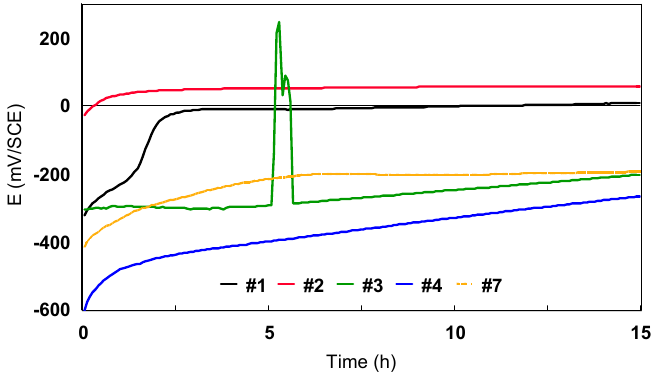
Figure 16. Open circuit potential vs. immersion time curves for bulk Ti-based alloys in artificial plasma bone. Table 6. Electrochemical parameters determined for Ti-based alloys in artificial plasma bone.